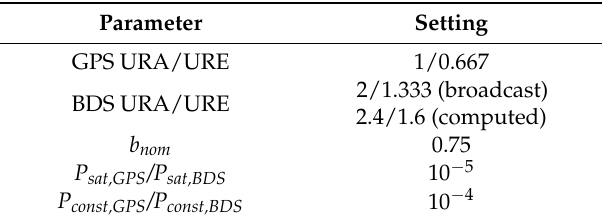
Table 2. ISM basic parameter Table 2 . ISM basic parameter settings.